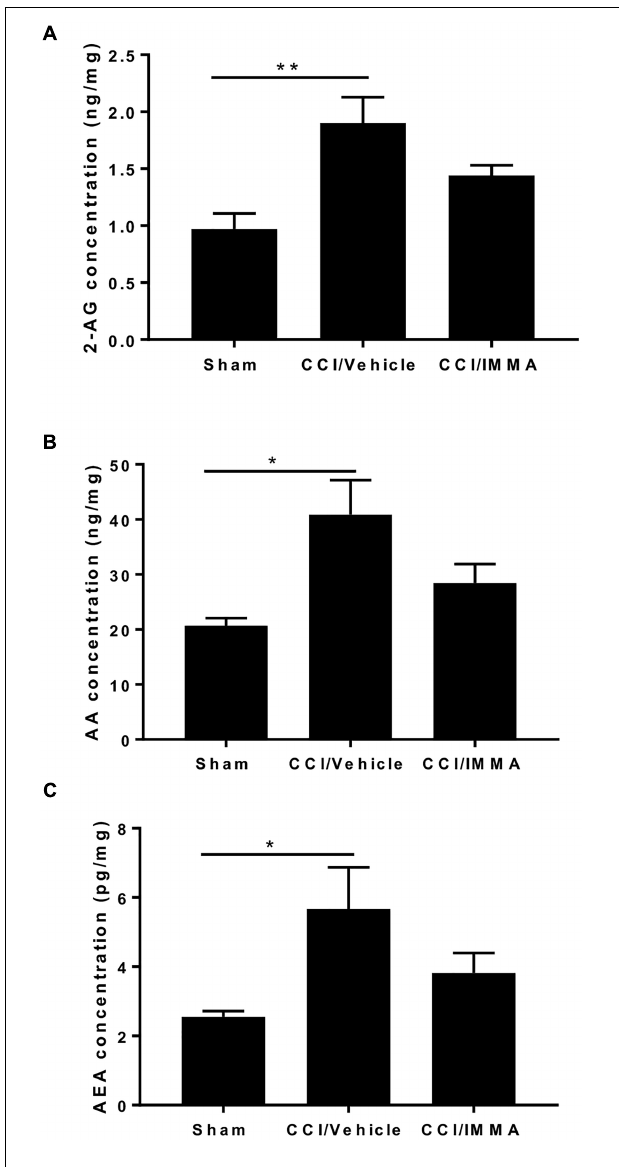
FIGURE 6 | IMMA treatment did not affect the increased levels of 2-AG, AA, and AEA in the CCI mouse sciatic nerve. Fresh sciatic nerve tissues from CCI mice 7 days after surgery were subjected to LS-MS/MS. The amount of 2-AG (A) , AA (B) , and AEA (C) was significantly increased in the CCI/vehicle group compared to the sham ( ∗ p < 0.05 and ∗∗ p < 0.01. n = 8/group). IMMA treatment slightly reduced the increased production of 2-AG, AA, and AEA elicited by CCI (A–C) . One-way ANOVA was used for comparing the differences among the sham, vehicle and IMMA treated groups. The Tukey-Kramer post hoc test was used for the